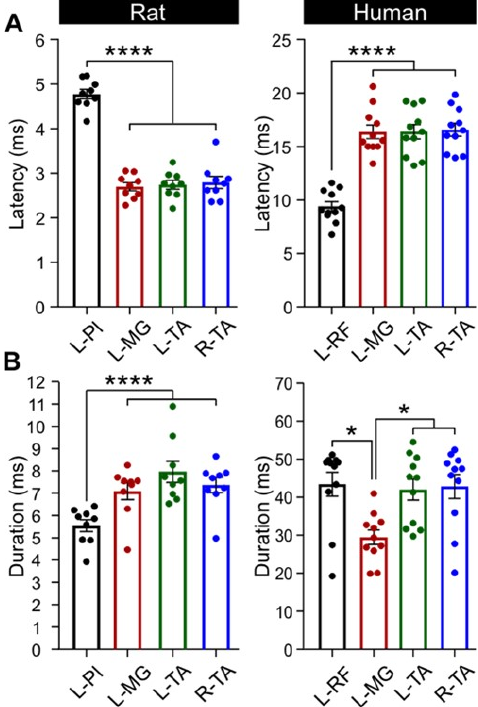
Figure 6. TEP latency and duration at maximal output. ( A ) L-Pl response latency was significantly longer in rats as compared to L-MG and L- and R-TA. In humans, L-RF latency was shorter as compared to ankle mucles. ( B ) In rats, the response duration was significanty shorter in L-Pl as compared to ankle muscles. In humans, MG response duration was significantly shorter than all other muscles. L, left; R, right; Pl, plantar muscle; MG, medial gastrocnemius; TA, tibialis anterior; RF, rectus femoris. * p < 0.05; **** p < 0.0001.